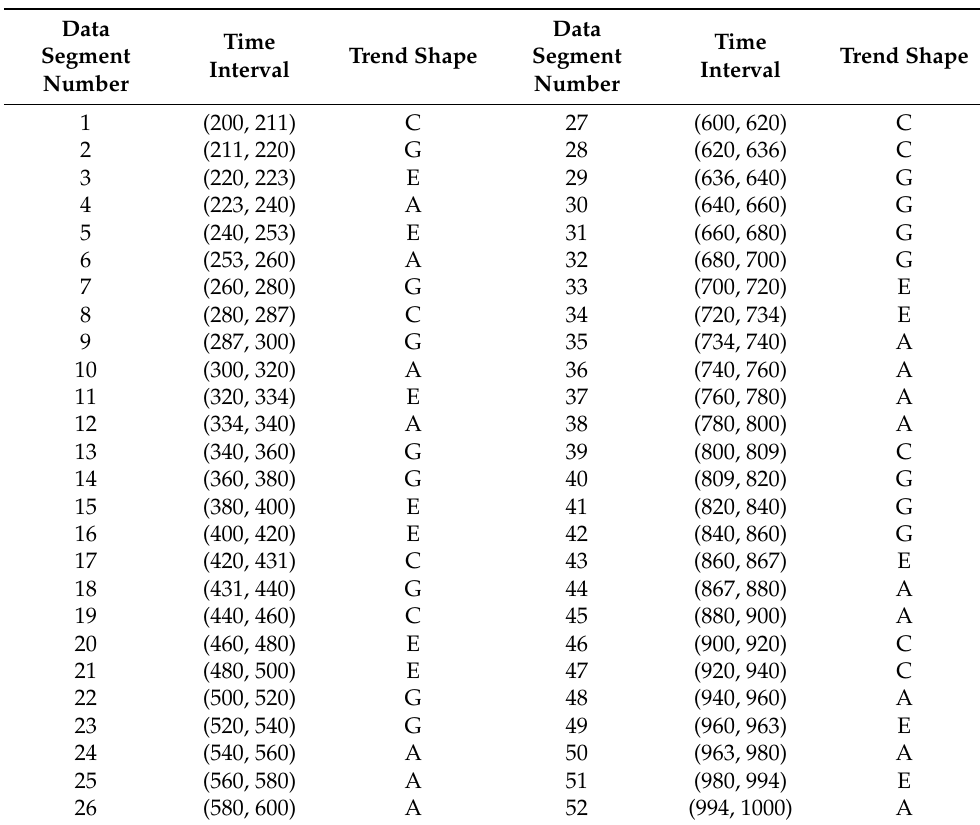
Table 2. Trend extraction results